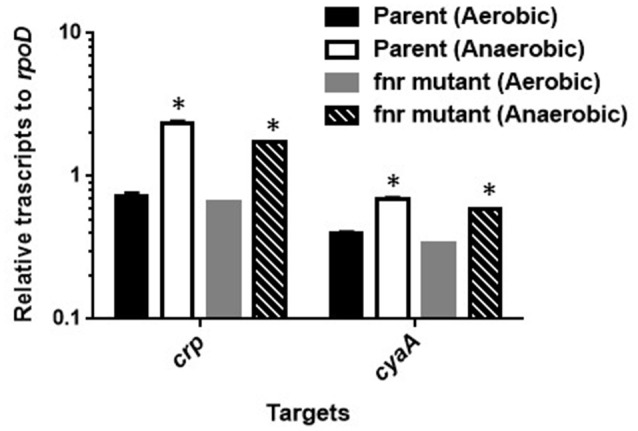
Transcript levels of crp and cyaA genes in the wild-type parent and the fur mutant strains grown under aerobic or anaerobic conditions. These transcript levels were described as relative values to that of rpoD (housekeeping gene). Data plotted are the means of two biological replicates, error bars indicate the ranges, *P < 0.01. Asterisks denote significance for values of mRNA level in bacterial cultures under anaerobic conditions relative to those under aerobic conditions.